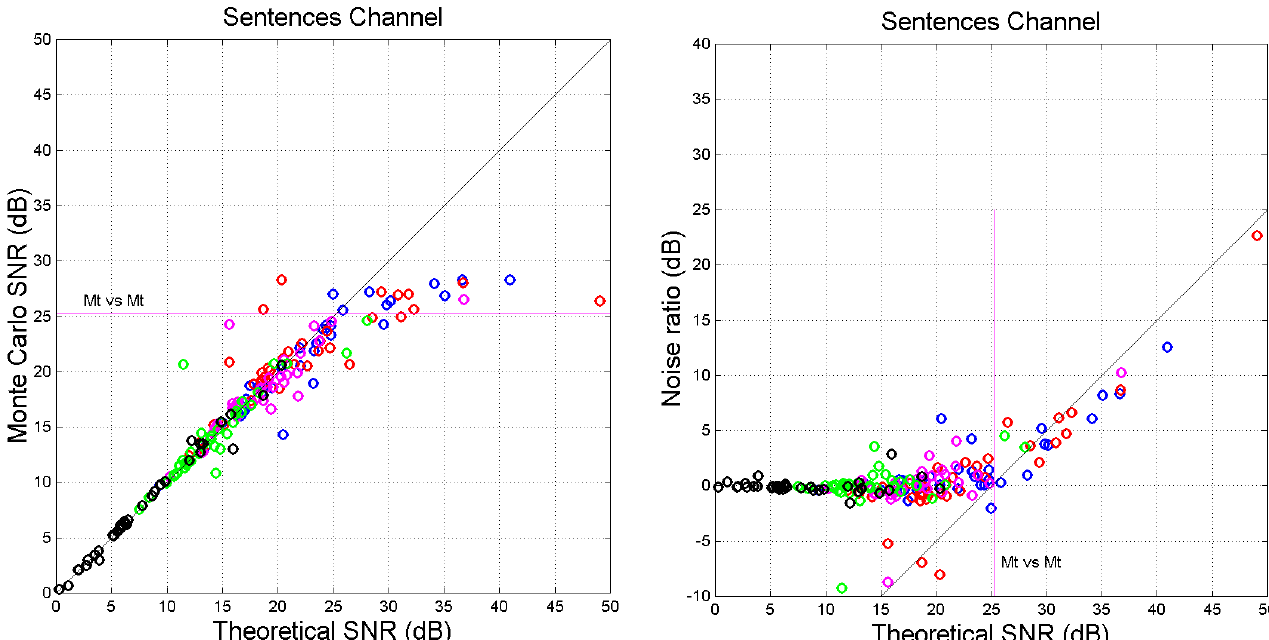
Γ − Γ dB , th dB , ex , i.e., ratio (expressed